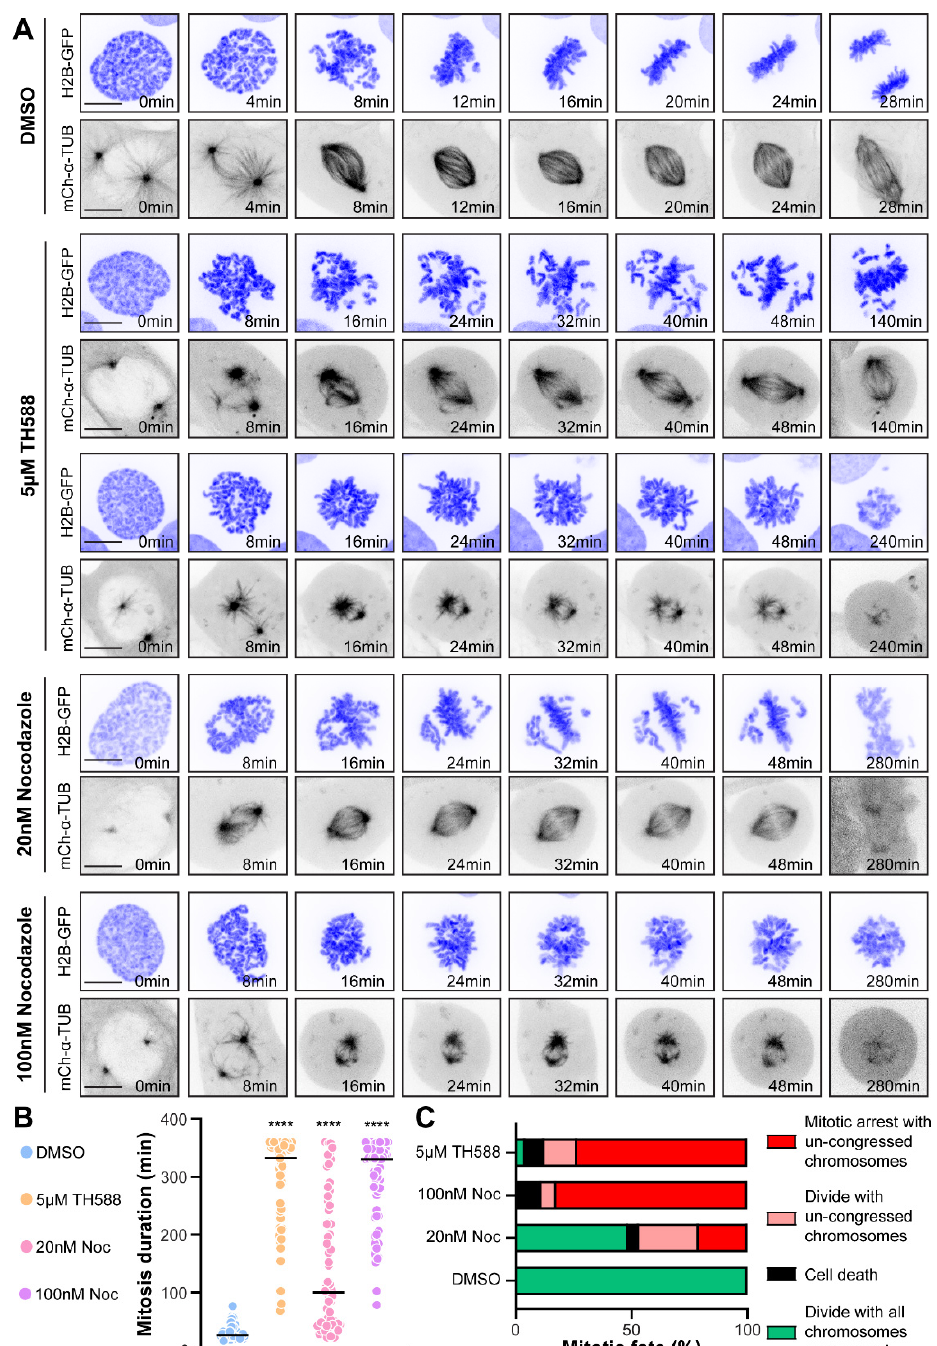
Figure 2. TH588 induces severe chromosome congression problems that lead to mitotic arrest, followed by the cell death or erroneous cell division. ( A ) Representative spinning disk confocal time-series of mitosis in U2OS cells stably expressing H2B-GFP/mCherry- α -tubulin undergoing indicated treatments. Scale bar 10 µm. ( B ) Quantification of duration of mitosis in U2OS cells undergoing indicated treatments. Scatter plot graphs with median are plotted from three independent experiments (n = 56 cells for DMSO, 49 cells for 5µM TH588, 63 cells for 100 nM nocodazole, and 65 cells for 20 nM nocodazole). ( C ) Quantification of the fate of mitotic cells from three independent experiments. **** p < 0.0001.